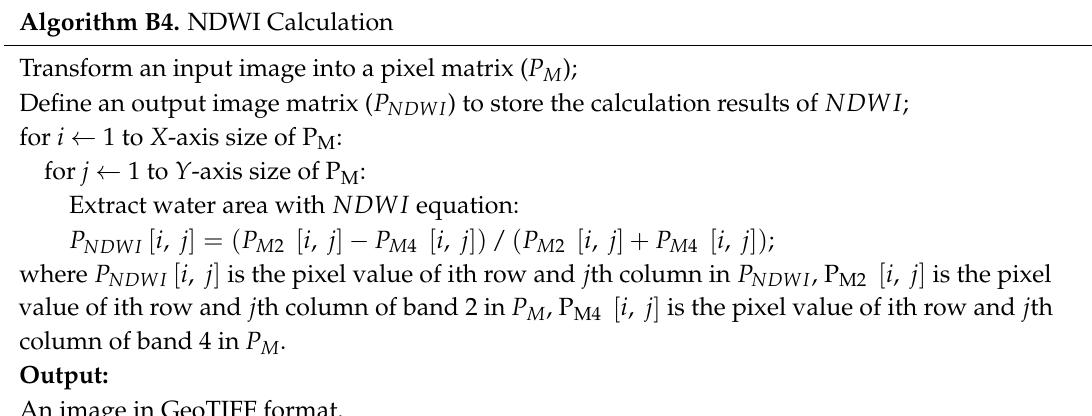
Algorithm B4. NDWI